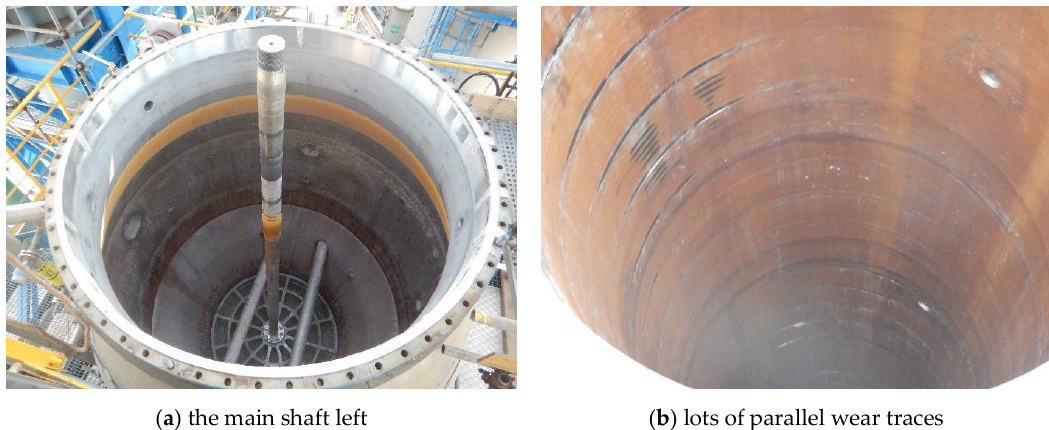
Figure 5. External appearances of the tray.